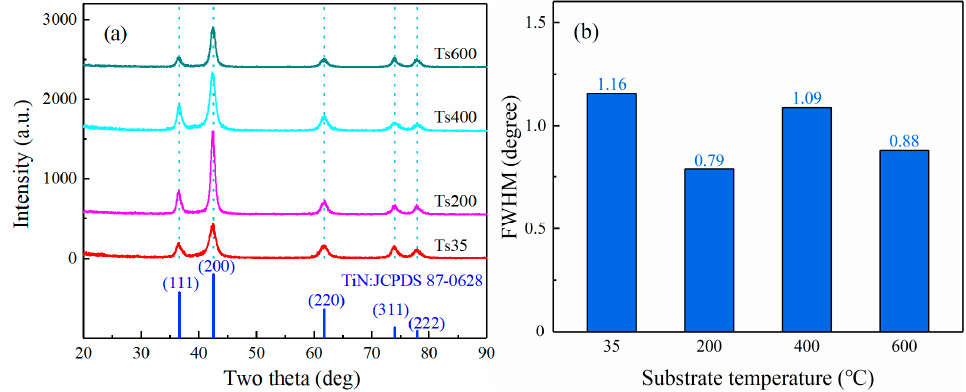
Figure 6. X-ray diffraction pattern and the full width at half maximum (FWHM) value of TiN coatings under different substrate temperatures: ( a ) XRD pattern; ( b ) FWHM value.